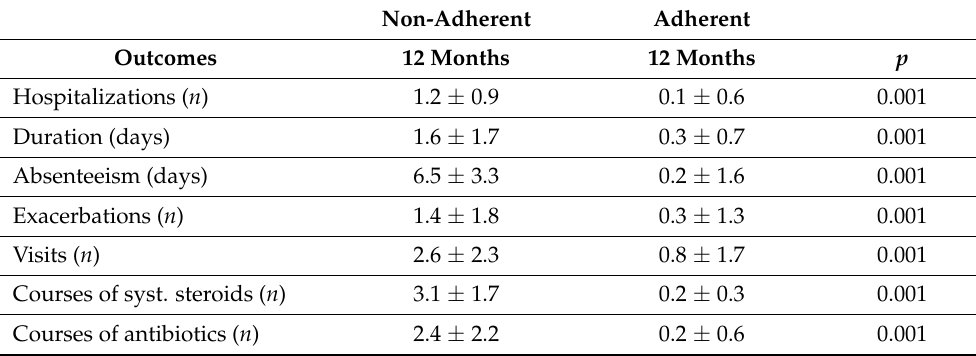
Table 2. Outcomes in non-adherent and adherent adolescents over 12 months, and corresponding statistical comparisons (means ± SD).